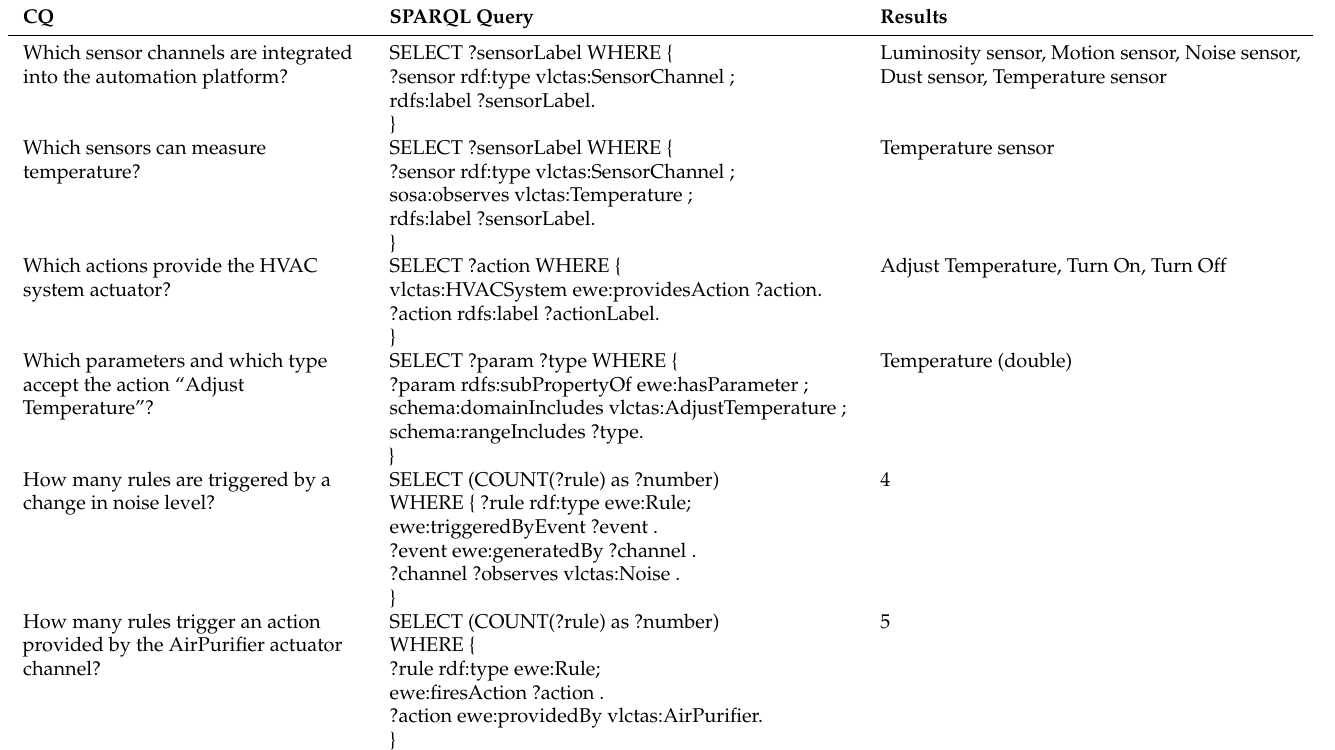
Table 1. Example CQs using the proposed model written in SPARQL.